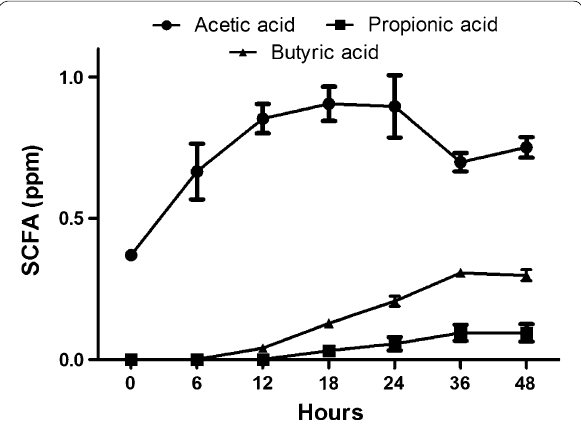
Fig. 5 Average SCFA concentrations at various pectin incubation